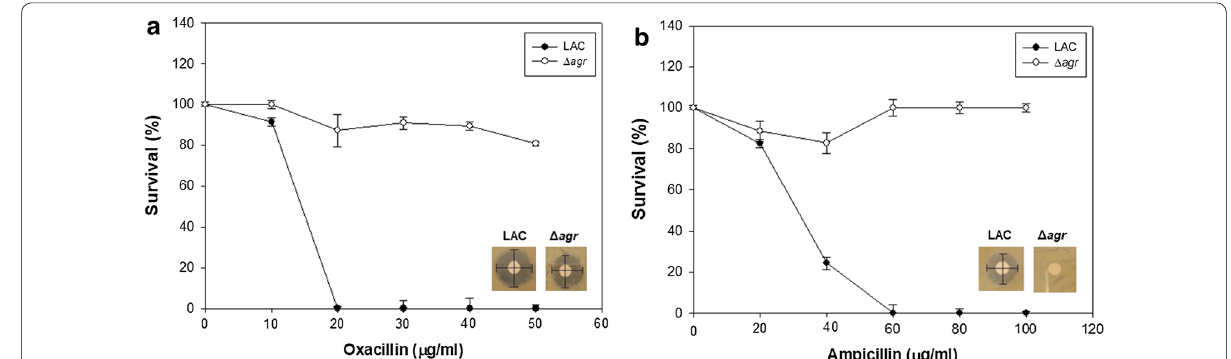
Fig. 1 Antibiotic susceptibility test of the LAC and Δ agr mutant strain with oxacillin and ampicillin. In the presence of 50 μg/mL of oxacillin and ampicillin the disk diffusion method was carried out. The error bars represent the standard deviation of three